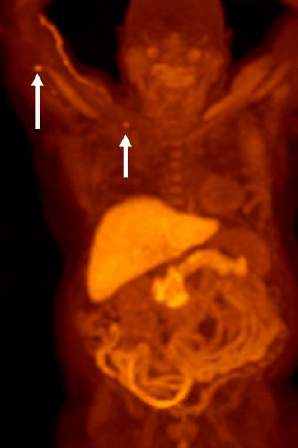
Figure 7. Fifty-six-year-old male with prostate cancer, status post-combination radiation and hor- mone therapy, now presenting with rising PSA. ( A ) Axumin-fused PET/CT image shows Axumin uptake within the prostate gland (arrow) concerning for local recurrence. MIP image ( B ) shows Ax- umin uptake within a chain of left peri-aortic lymph nodes (arrows) extending to the level of the kidneys.